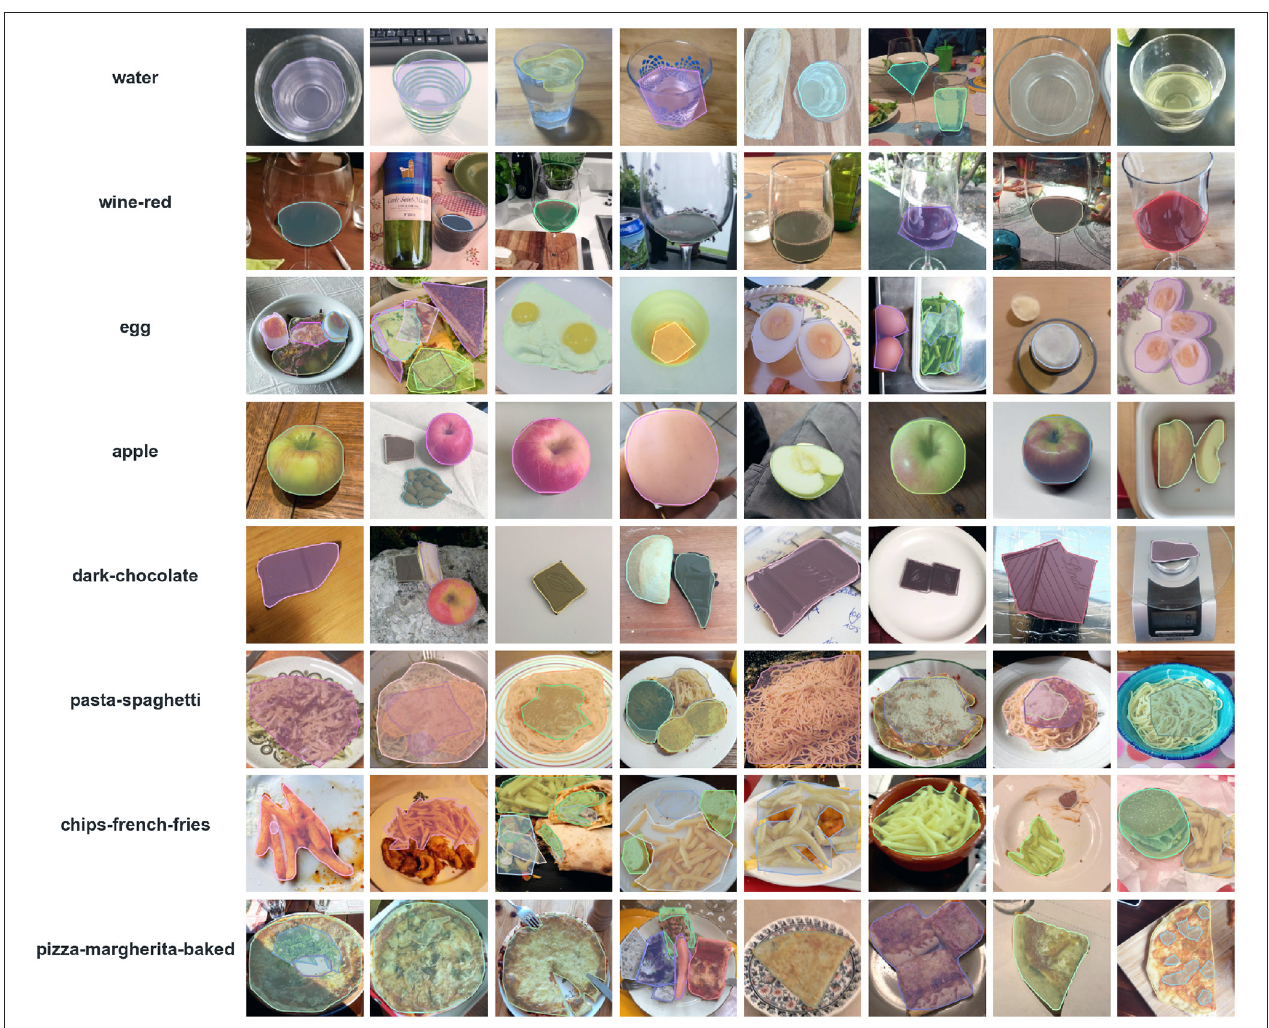
FIGURE 2 | Sample images and corresponding annotations for some of common food classes in myFoodRepo